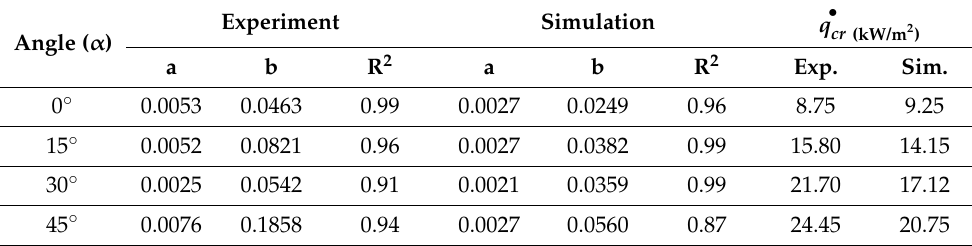
Figure 4. Relationships between (cid:112) t ig and radiant heat flux according to Equation (1). ( a ) Experimental results and ( b ) numerical model results. • q cr ) for ignition for different sample Table 2. Critical heat flux (